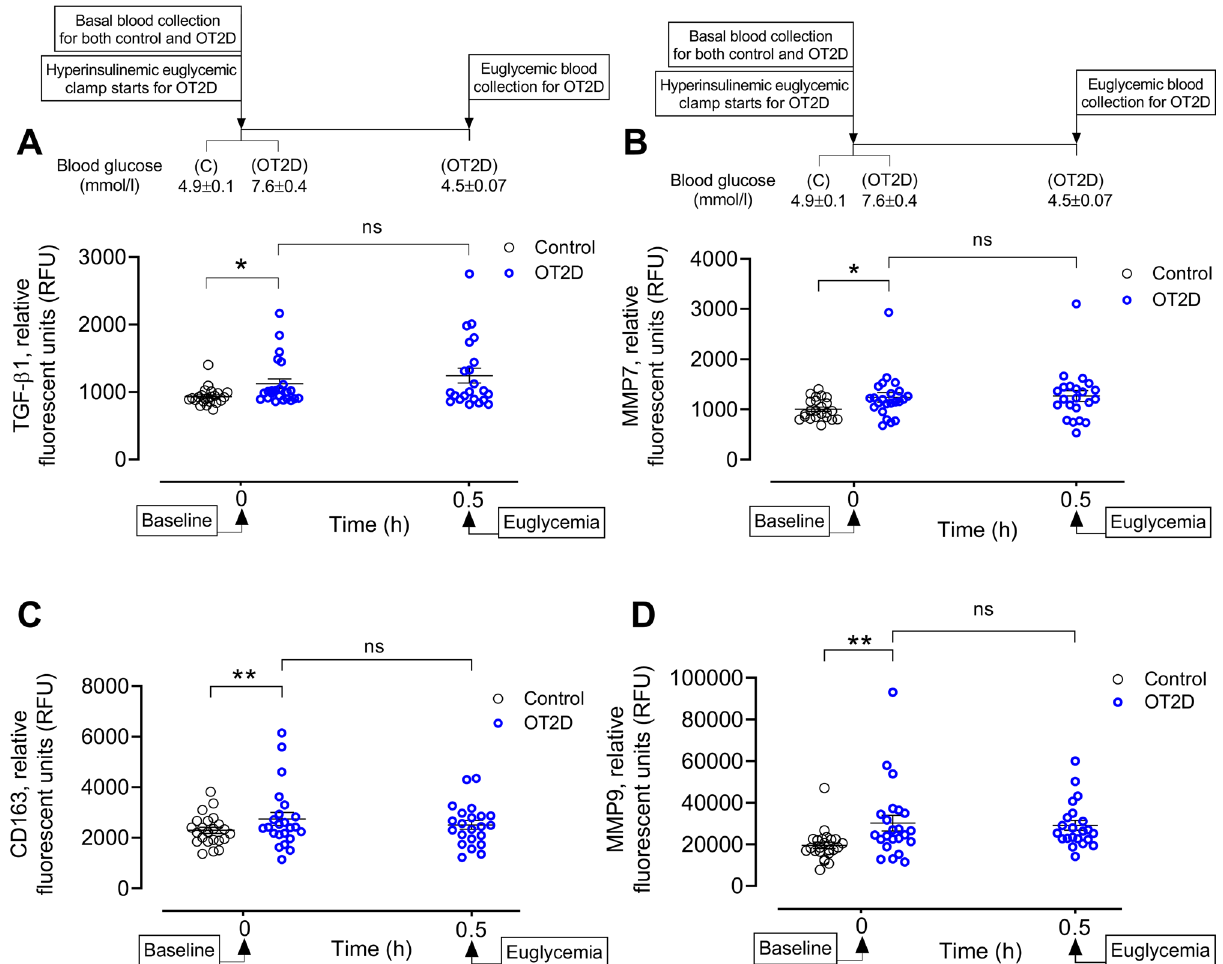
Figure 3. Circulatory levels of activated M2 macrophage markers in the steady state of obese type 2 diabetes (OT2D). Plasma TGF-β1 ( A ), CD163 ( B ), MMP7 ( C ) and MMP9 ( D ) levels in control subjects (black circles) and obese subjects with T2D (blue circles). Basal levels of plasma TGF-β1, CD163, MMP7 and MMP9 were higher in OT2D compared to control (1123 ± 72 vs 933 ± 27 RFU of TGF-β1, OT2D vs control, p < 0.01; 2748 ± 256 vs 2297 ± 124 RFU of CD163, OT2D vs control, p < 0.05). Two matrix metalloproteinases MMP7 and MMP9 were also increased in OT2D (1242 ± 93 vs 1005 ± 42 RFU of MMP7, OT2D vs control, p < 0.05 and 30,193 ± 3746 vs 19,532 ± 1562 RFU of MMP9, OT2D vs control, p < 0.01). Acute normalization of glycemia had no effect on levels of LBP, CD80 or CD38 in T2D subjects (A-D). Data were presented as mean ± SEM. *, p < 0.05, **, p <